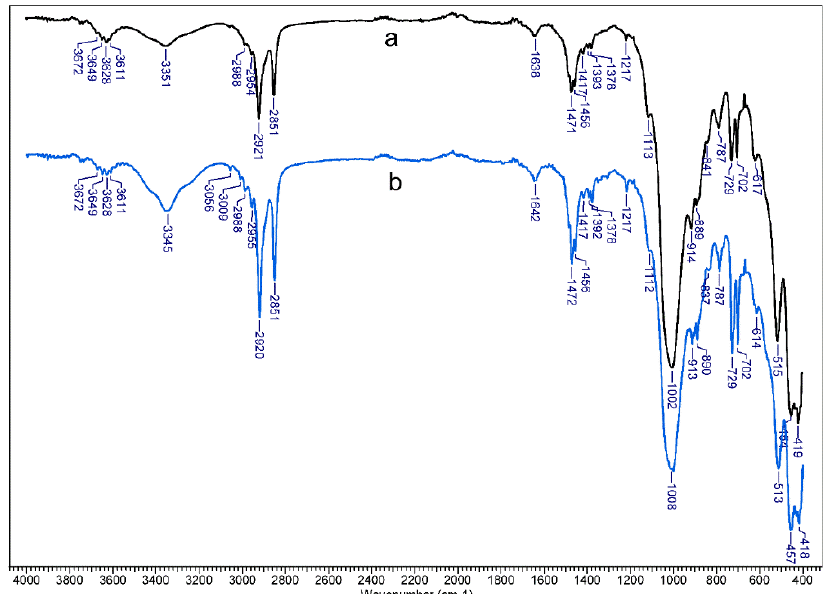
Figure 3. FT-IR spectra of ODTMA–clay sample under: (a) MW free; (b) MW heated.